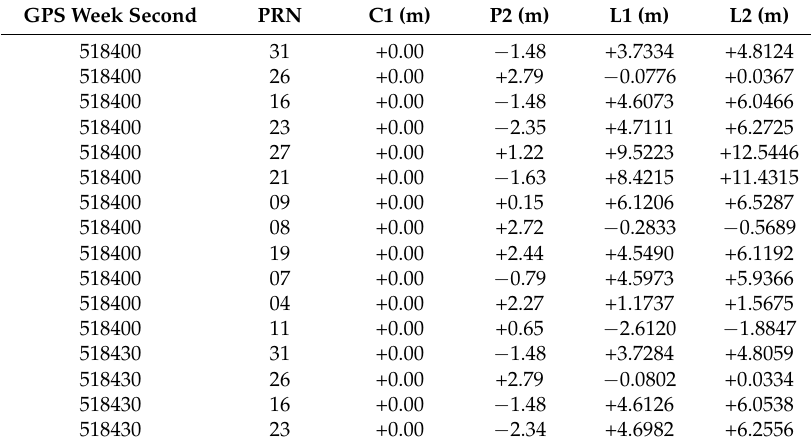
Table A3. Sample satellite bias corrections provided by SSR messages.